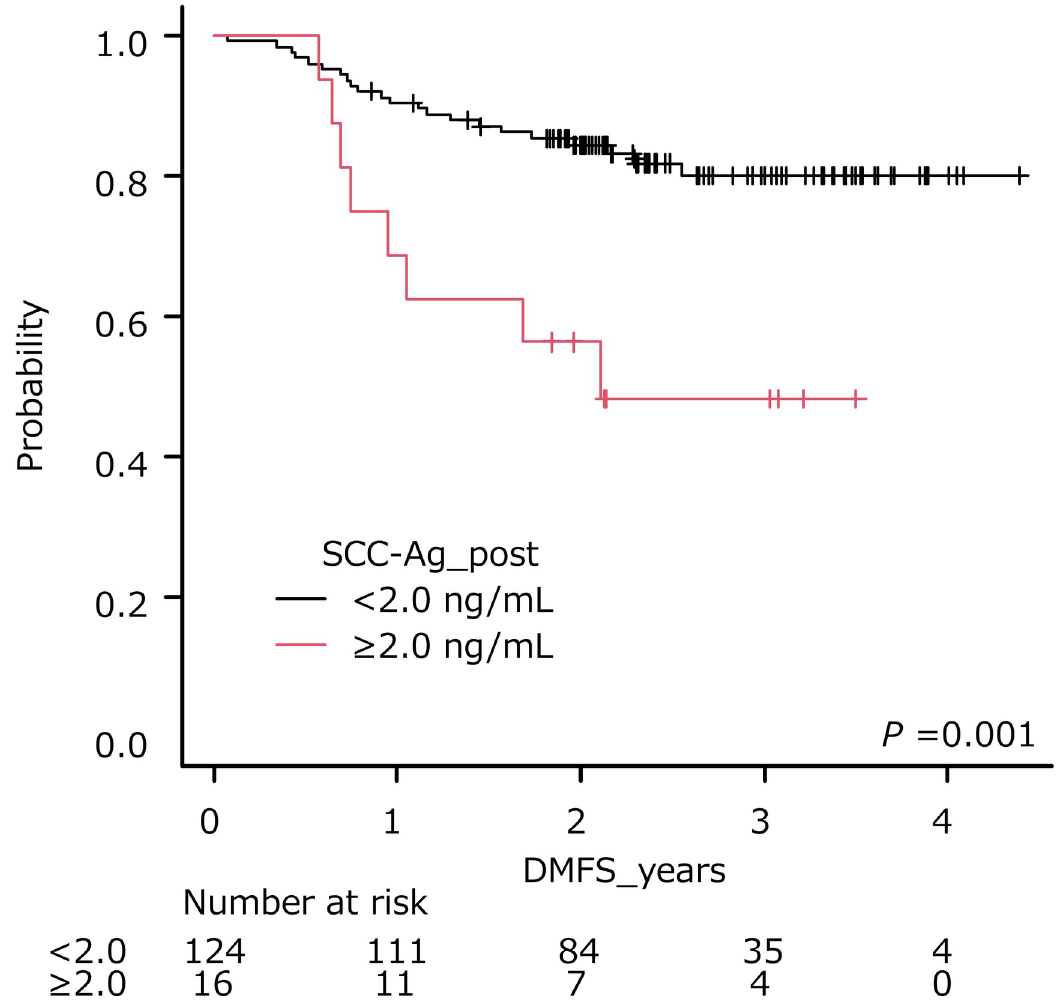
Fig 6. Distant metastasis-free survival of patients stratified by posttreatment SCC-Ag levels. Higher levels of pretreatment SCC-Ag ( � 2.0 ng/ml) were significantly associated with poorer outcome ( P = 0.001).